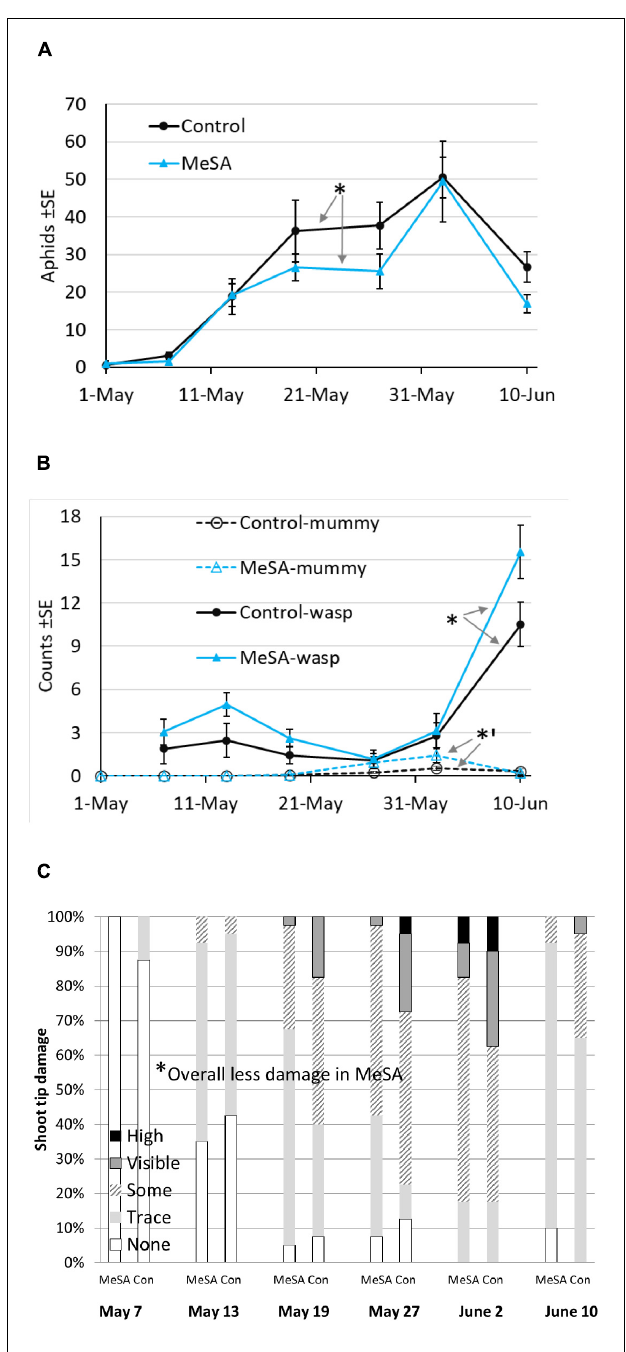
FIGURE 1 | Mean number of aphids on shoot tips (A) , Pseudopraon wasps on sticky cards and aphid mummies on shoot tips (B) , and percent of trees by damage ranking (C) in a container-grown spruce field study during year 1. Asterisk indicates a difference between treatments over season, GLMM ∗ p < 0.05, ∗ ’ p = 0.07.